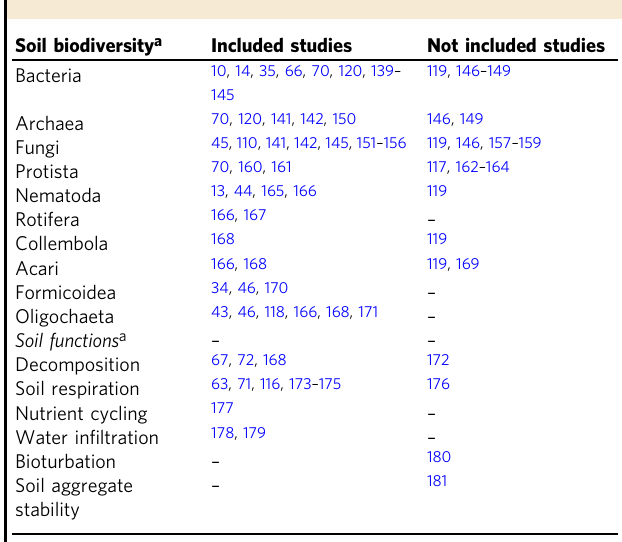
Table 2 List of studies included in the current